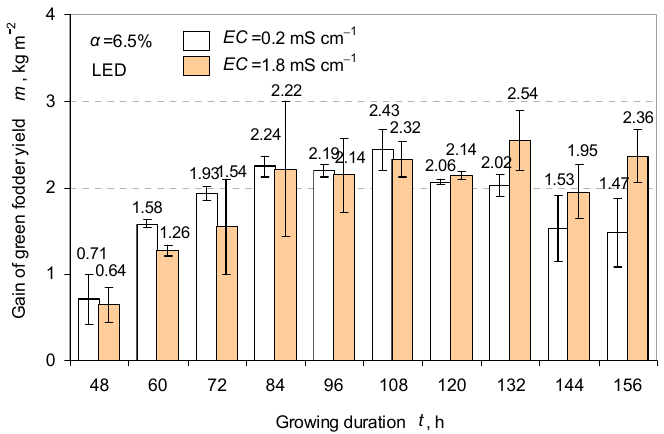
Figure 8. Variation in mass gain of fodder during growing period using indoor lighting. Each vertical bar is 95% confidence interval.